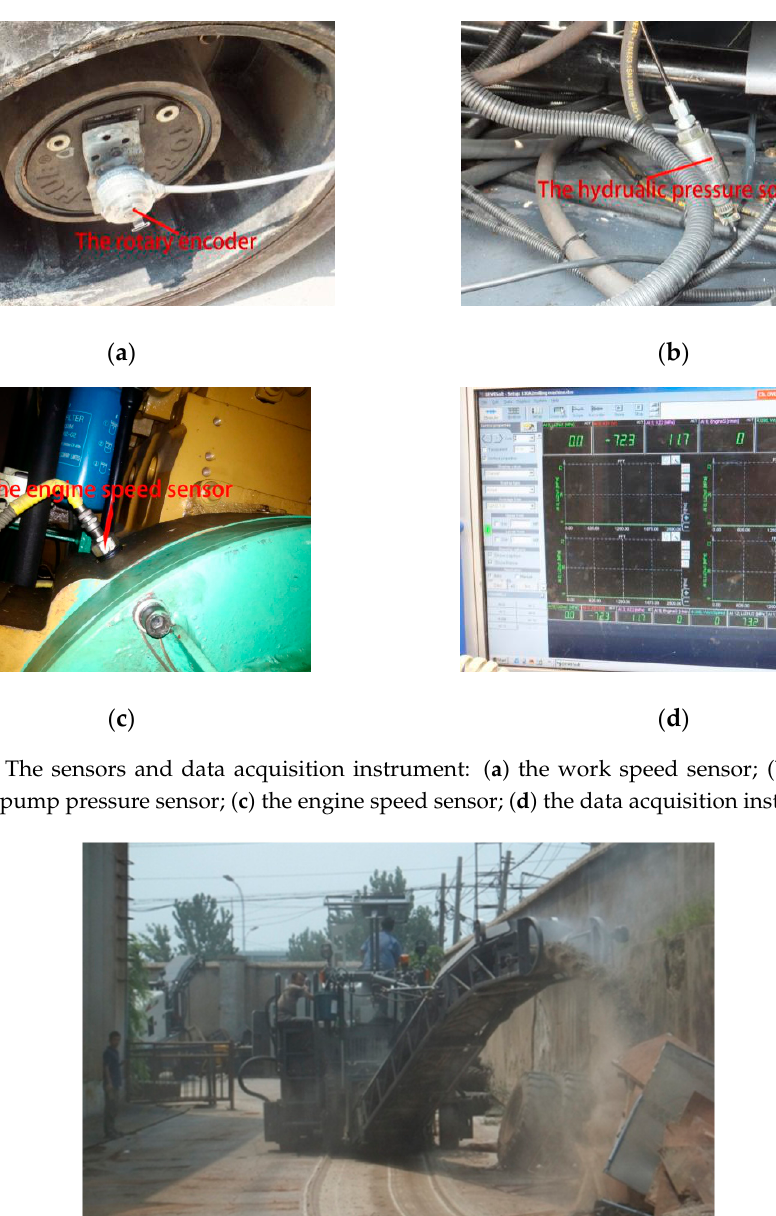
Figure 11. The milled cement pavement.